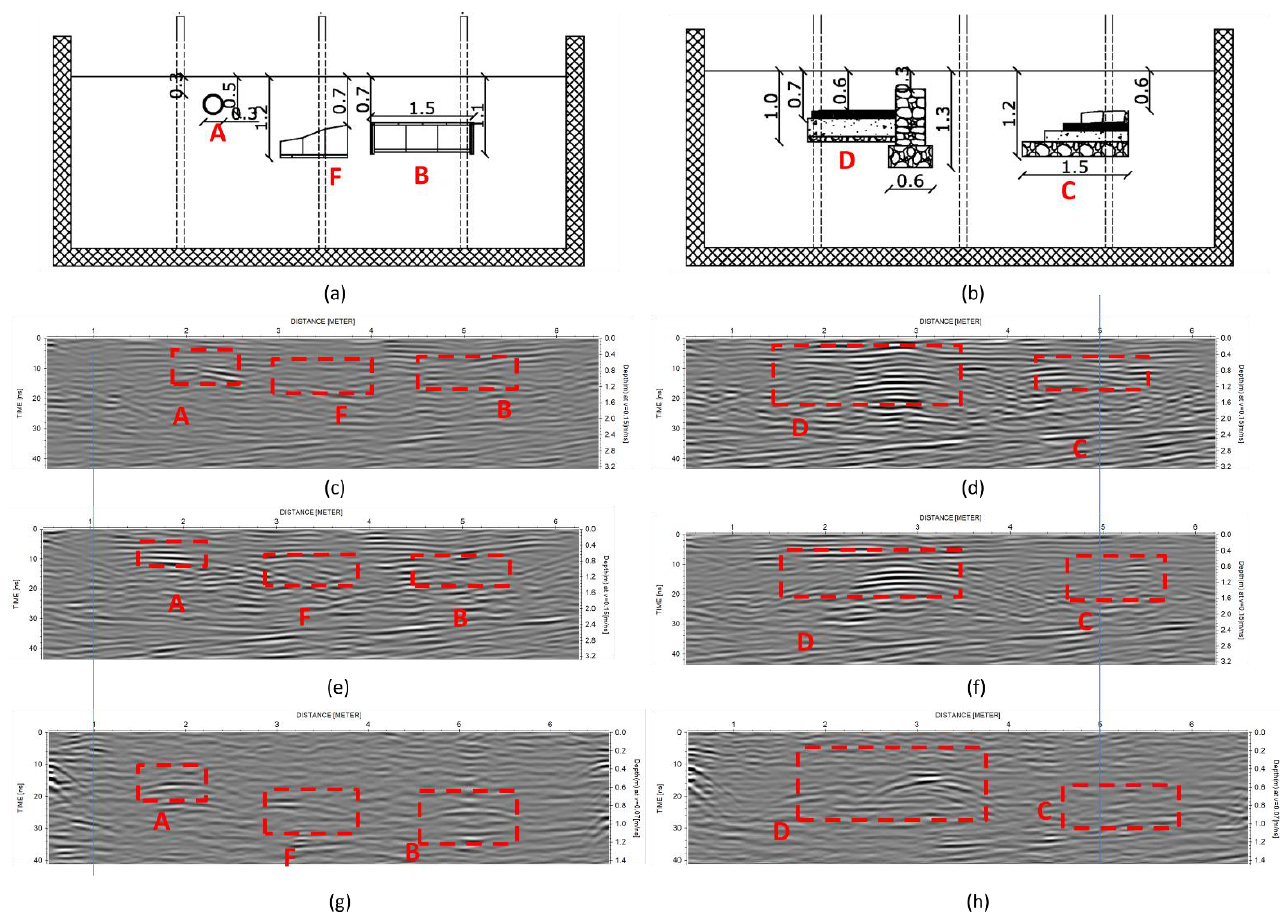
Figure 15. Comparison of the radargrams acquired in correspondence of the S1 ( a ) and S2 ( b ) that represent the main sections of the test site ( c ). The radargrams acquired in WL3 ( c , d ), WL2 ( e , f ), and WL1 ( g , h ) allow to detect the different structures (anomalies in red).